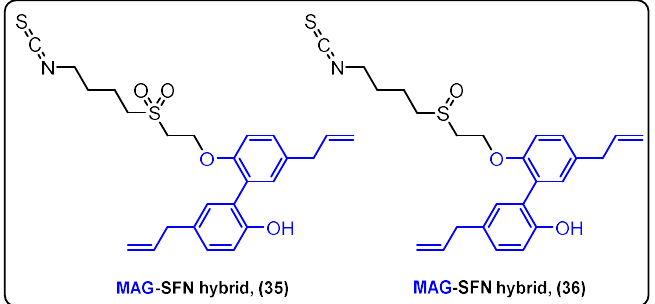
Figure 11. Magnolol–sulforaphane hybrids.